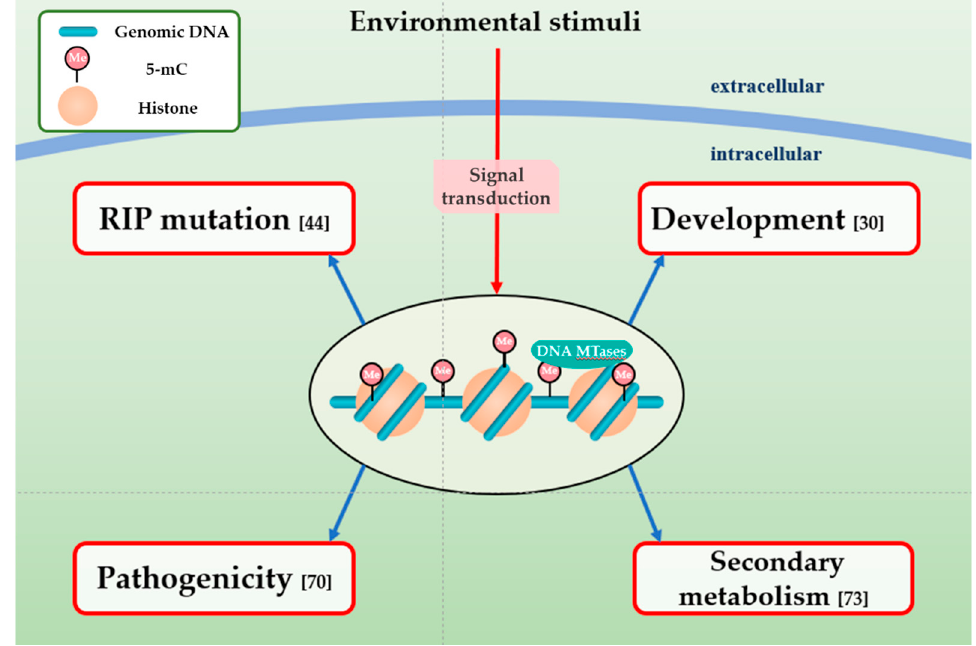
Figure 3. Functions of DNA methylation in fungal pathogens. DNA methylation in fungal plant pathogens can respond to environmental stimuli and involved in many biological processes, including RIP mutation, development, pathogenicity, and secondary metabolism.